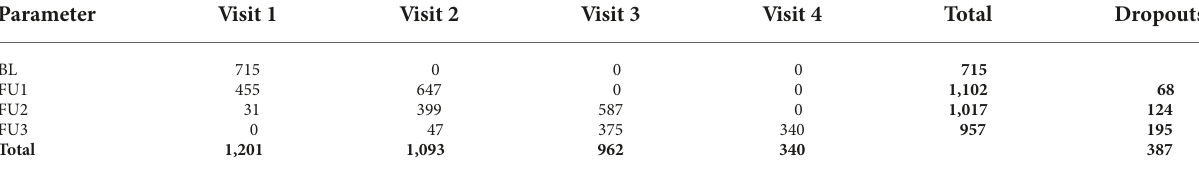
(s), gait velocity variability (m/s), step length variability (m), step time variability (s), stride time variability(s), swing time variability (s), stance time variability (s), step length asymmetry (m), swing time asymmetry (s), and stance time asymmetry (s). The variability parameters were calculated from the standard deviation of each original parameter (e.g., length, time), and asymmetry was calculated as Average left − Average right of the original parameter (Del Din et al.,